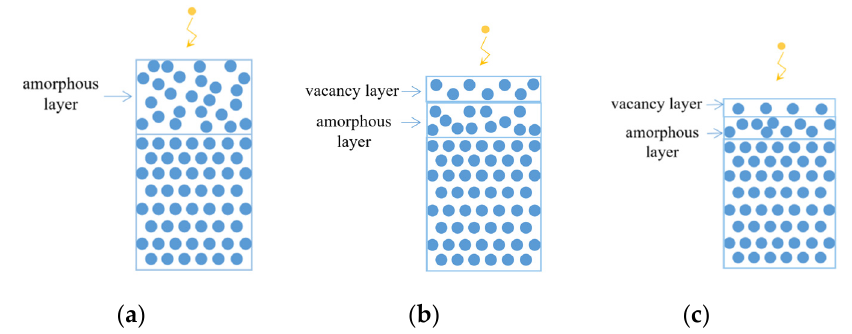
Figure 11. Photothermal weak absorption test platform. The detection parameters are shown in Table 12. Table 12. Detection parameters. Item Level Irradiation laser wavelength